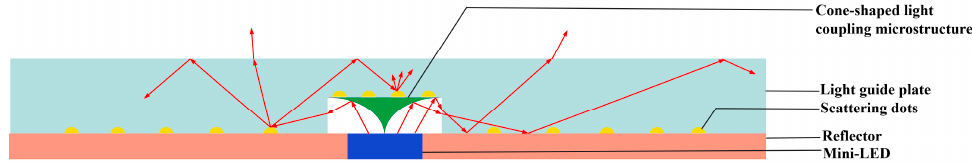
Figure 2. Schematic of the light propagation in the LGP.